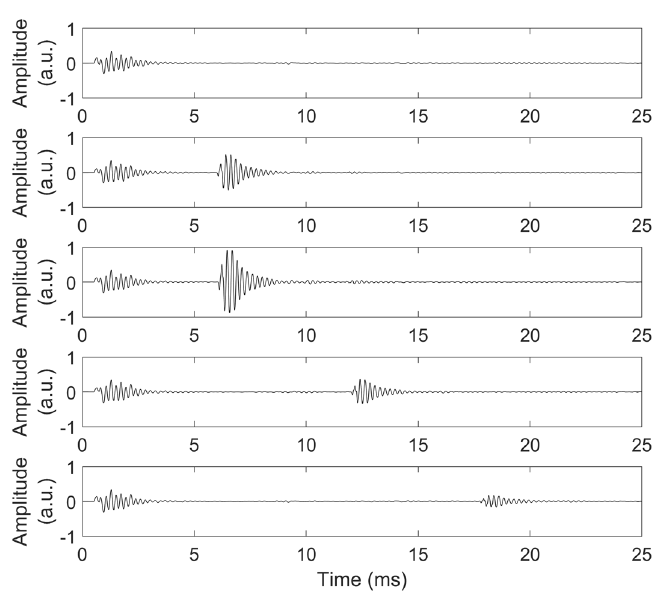
Figure 4. Waveform plots (left channel only) of echolocation sound recordings used during the experiment. From top to bottom: Object Absent, 17.5-cm disk at 1 m, 26.5-cm disk at 1 m, 26.5-cm disk at 2 m, 26.5-cm disk at 3 m. a.u. – arbitray